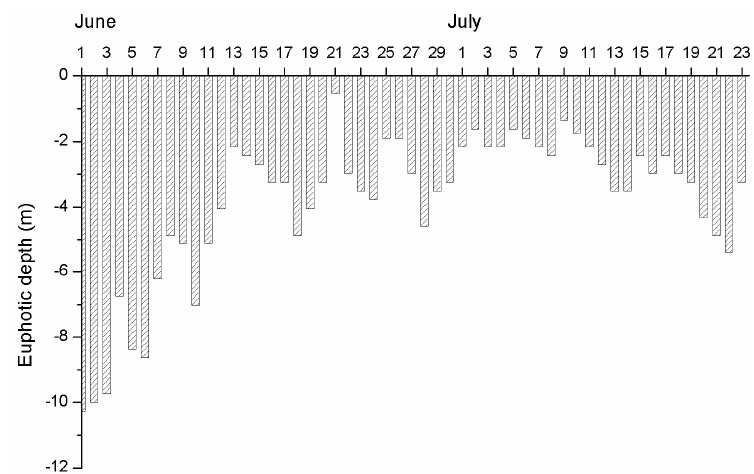
Figure 2. Variations in the daily photosynthetically active radiation (PAR) and the euphotic depth of Xiangxi Bay from 1 June to 23 July, 2008.